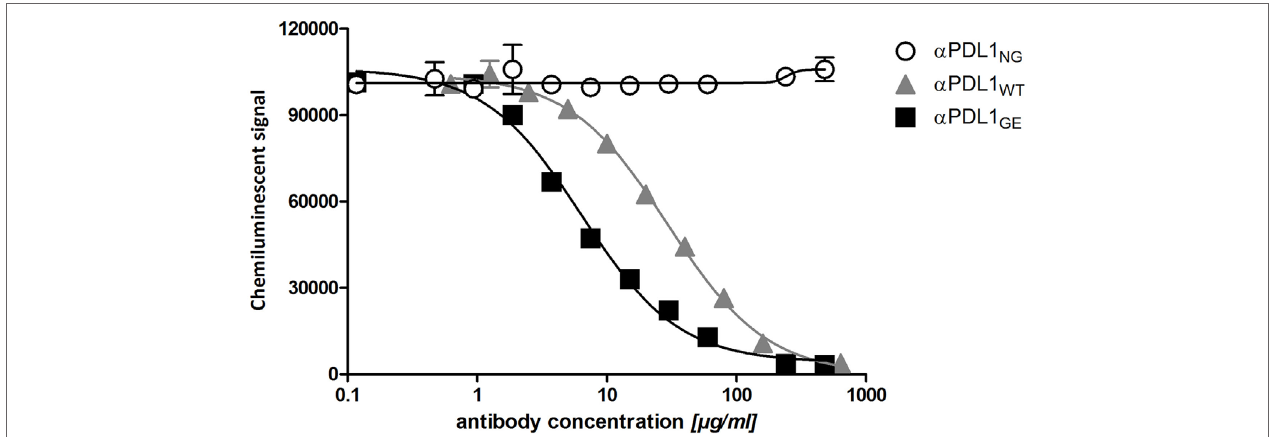
FigUre 1 | Glyco-engineered anti-human programmed death-ligand 1 (PD-L1) antibody shows an enhanced binding to Fc γ RIIIa. A competitive Fc γ RIIIa AlphaLISA was performed for the three anti-PD-L1 variants. Thereby the test antibody competes with antibody-conjugated acceptor beads for binding to Fc γ RIIIa-conjugated donor beads. The chemiluminescent signal as a result of close proximity of the donor and acceptor beads was plotted against increasing concentrations of α PDL1 NG (open circles), α PDL1 WT (gray triangles), and α PDL1 GE (black squares). Statistics: mean and SD were plotted in the graph. Data are representative of two independent